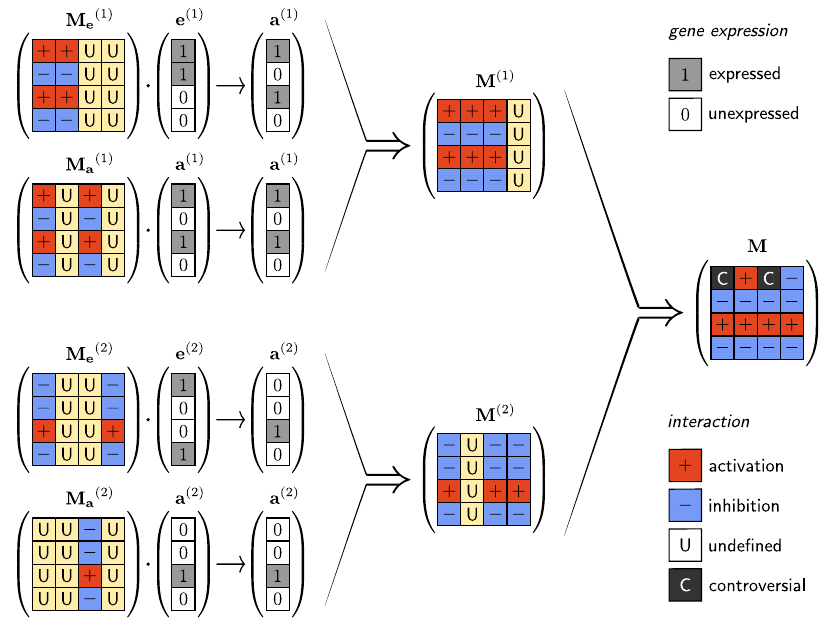
Fig 1. Illustration of the construction rules of interaction matrices based on theoretical considerations on the optimal pairwise interaction types between genes. e (1) and a (1) are the first embryo-adult pair, e (2) and a (2) . the second pair. Depending on the combination of gene expressions e ð n Þ and a ð n Þ in an embryo-adult vector pair ( n = 1,2), i i element of the interaction matrix can be positive ( 0 + 0 , activation), negative ( 0 − 0 , inhibition), or undefined ( 0 U 0 ). an m ij To ensure correct development ð M ð n Þ matrices must have the structure indicated in the figure. (If e ð n Þ ! a ð n Þ Þ the M ð n Þ e e e ð n Þ j ¼ 1 and a ð n Þ i ¼ 1 , then m ð n Þ ij = 0 + 0 ; if e ð n Þ j ¼ 1 and a ð n Þ i ¼ 0 , then m ð n Þ ij = 0 − 0 ; if e ð n Þ j ¼ 0 , then m ð n Þ ij = 0 U 0 ; irrespective of the value of a ð n Þ .) A similar argument holds for the stability criteria ð M ð n Þ matrices. a ð n Þ ! a ð n Þ Þ and results in the M ð n Þ i a a By combining M ð n Þ and M ð n Þ the resulting M ( n ) fulfills both the attractivity and stability criteria. The combination rules e a are the following: (+,+) ! +; ( − , − ) ! − ;( ± ,U) ! ± ; and ( ± , � ) ! C, which can be done practically by taking the element- wise average of the two matrices. The ultimate combination of all M ( n ) s results in a matrix that fulfills the attraction and stability criteria for all different embryo-adult pairs.